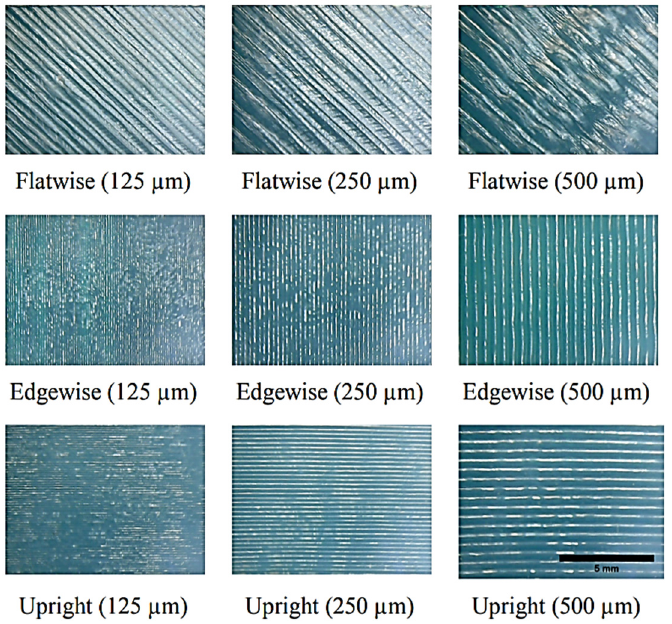
Figure 11. SEM images of surfaces of specimens with different print orientations and layer thicknesses (loading orientation ↕ ) Reprinted with permission from Ref. [88]. 2017, Springer Nature.